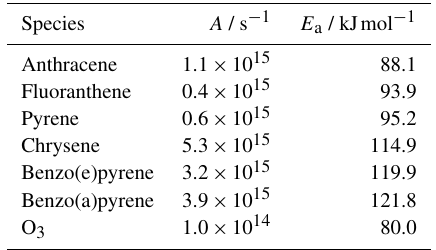
Table A1. Mass-transport parameters to determine the desorption rate coefficients of PAHs and O 3 ( k des = Ae − E A /RT ): Arrhenius parameter A and activation energy of desorption E A (Guilloteau et al., 2008,